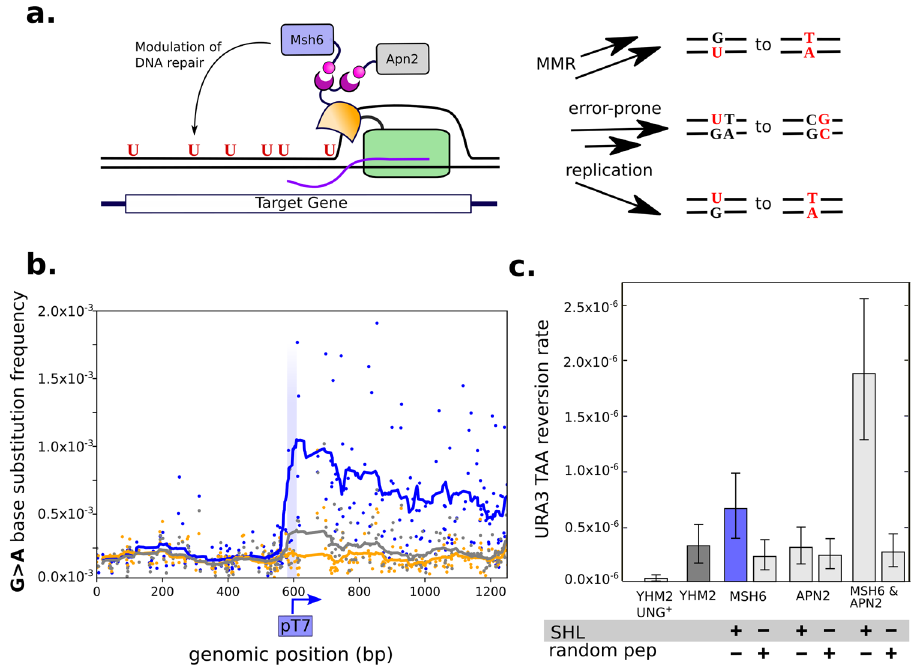
Fig. 2 Mutational spectrum is tuned by engineered targeting of repair factors. a Schematic of DNA-repair factor targeting using SH3 domains (purple) fused to integrated PmCDA1-T7 RNAP and SHL domains (pink) fused to host DNA-repair proteins. Localization of repair proteins initiates different mutational outcomes compared to PmCDA1-T7 RNAP alone. b Mutation frequencies for G > A substitutions plotted by position along URA3 for YHM2. MSH6 (blue), YHM2 (gray), and YHM2.P T7 KO (yellow) when induced with 100 nM β -estradiol. In order to match YHM2 and YHM2.P T7 KO, data from YHM2.P T7 KO is off-set to account for the gap created by the 23 bp insertion which disrupts P T7 . Mutation frequencies for all other base substitutions are shown in Supplementary Fig. 8b. Mutation data generated by next-generation sequencing at the URA3 locus as described in “ Methods ” . c A/T targeted mutation rate in strain YHM2.TAA having Apn2p and Msh6p DNA-repair proteins tagged with an SHL peptide or short random peptide. A/T rate is measured by reversion of a TAA stop codon in URA3 and quanti fi ed using the Falcor algorithm. Error bars represent 95% con fi dence intervals measured from 24 independent cultures induced with 100 nM β -estradiol. Source data are available as a Source data fi data indicate that over 99% of induced mutations are C > T transitions (Fig. 1e, Supplementary Fig. 6).